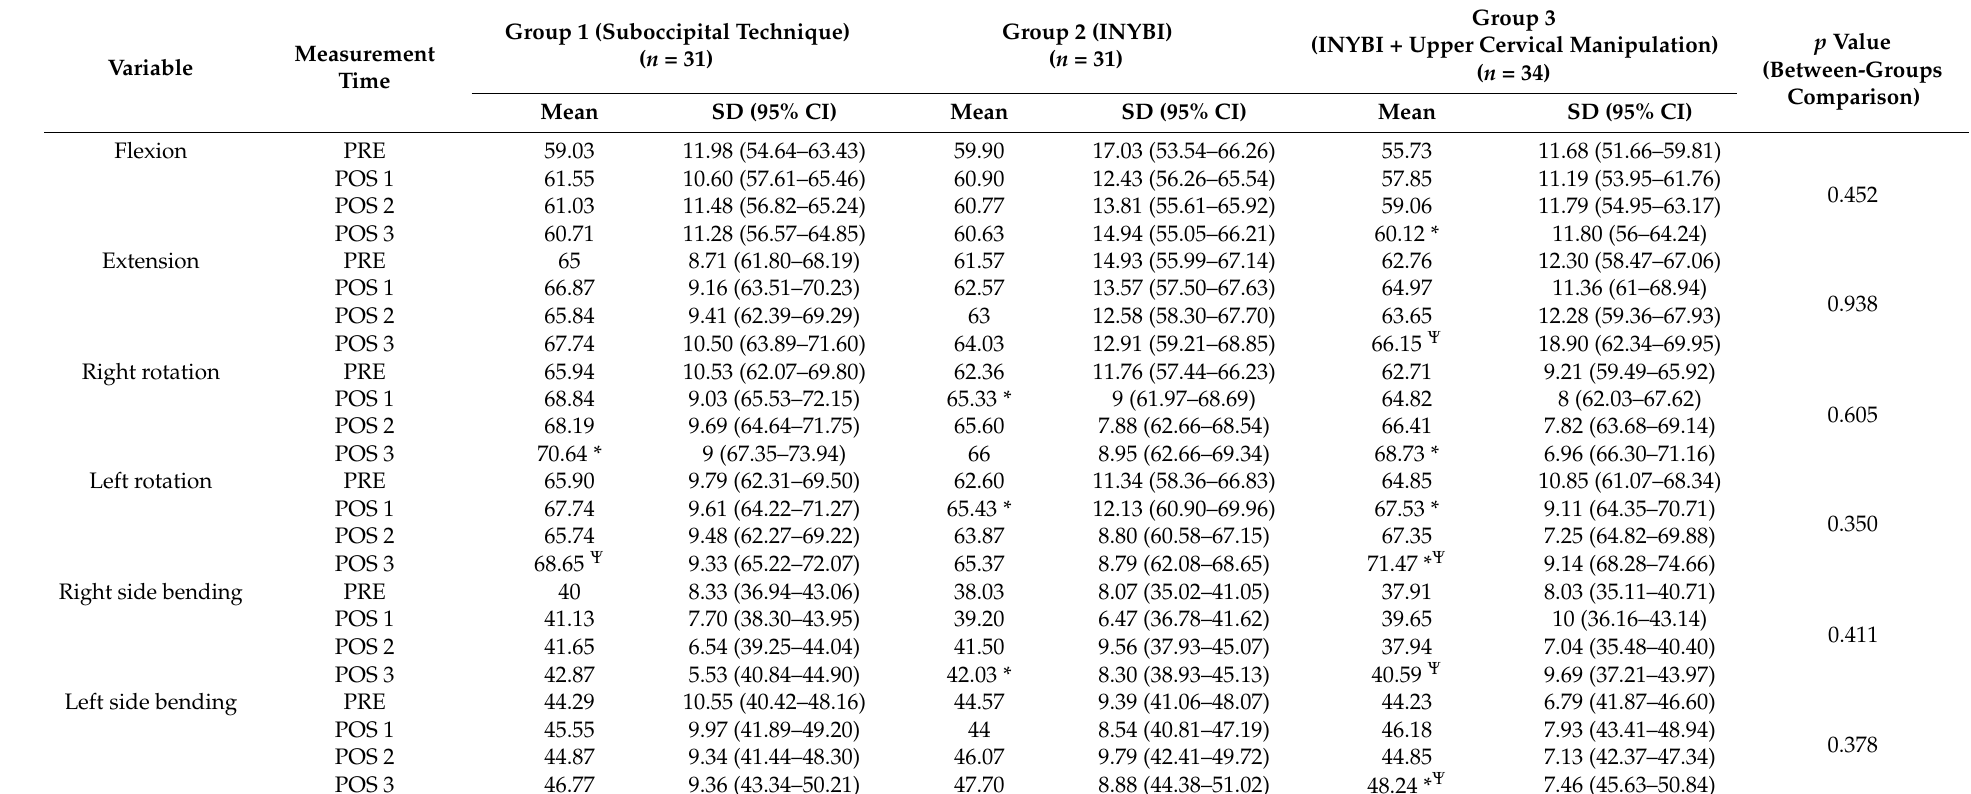
Table 2. PRE and POST Cervical Mobility Measurements